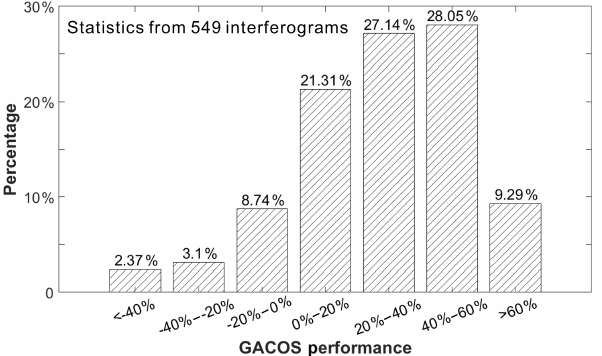
Figure 4. GACOS performance statistics from 549